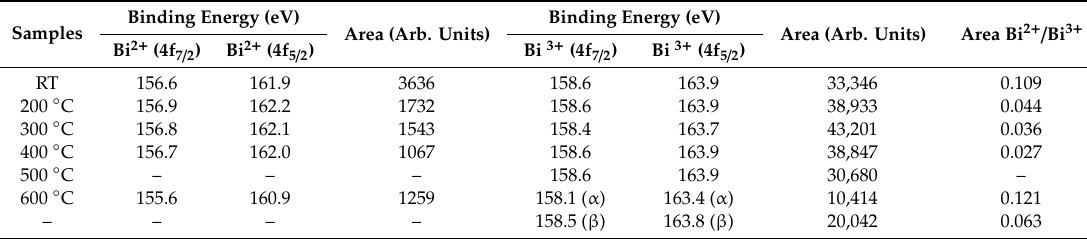
Figure 14. High ‐ resolution XPS spectra of Bi 4f for Bi 2 O 3 :Ho 3+ thin films deposited at different Figure 14. High-resolution XPS spectra of Bi 4f for Bi 2 O 3 :Ho 3 + thin films deposited at di ff erent substrate substrate temperatures: ( a ) RT, ( b ) 200 °C ( c ) 300 °C, ( d ) 400 °C, ( e ) 500 °C and ( f ) 600 °C. temperatures: ( a ) RT, ( b ) 200 ◦ C ( c ) 300 ◦ C, ( d ) 400 ◦ C, ( e ) 500 ◦ C and ( f ) 600 ◦ C. Table 4. Peak positions and areas of the 4f Bi XPS peaks of the Bi 2 O 3 :Ho 3 + thin films deposited at Table 4. Peak positions and areas of the 4f Bi XPS peaks of the Bi 2 O 3 :Ho 3+ thin films deposited at di ff erent substrate different substrate temperatures.